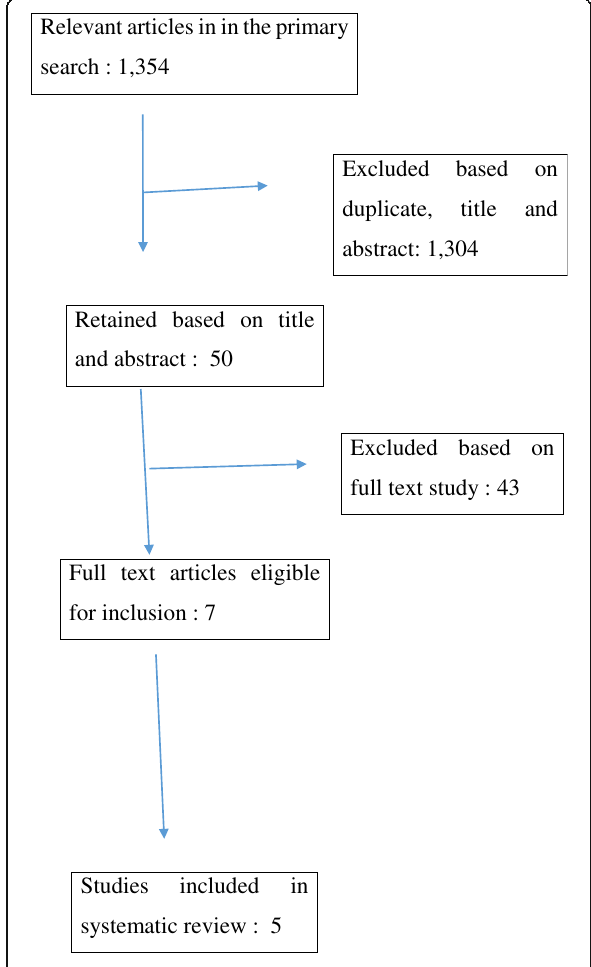
Fig. 1 PRISMA flow diagram: summary of search strategy in this